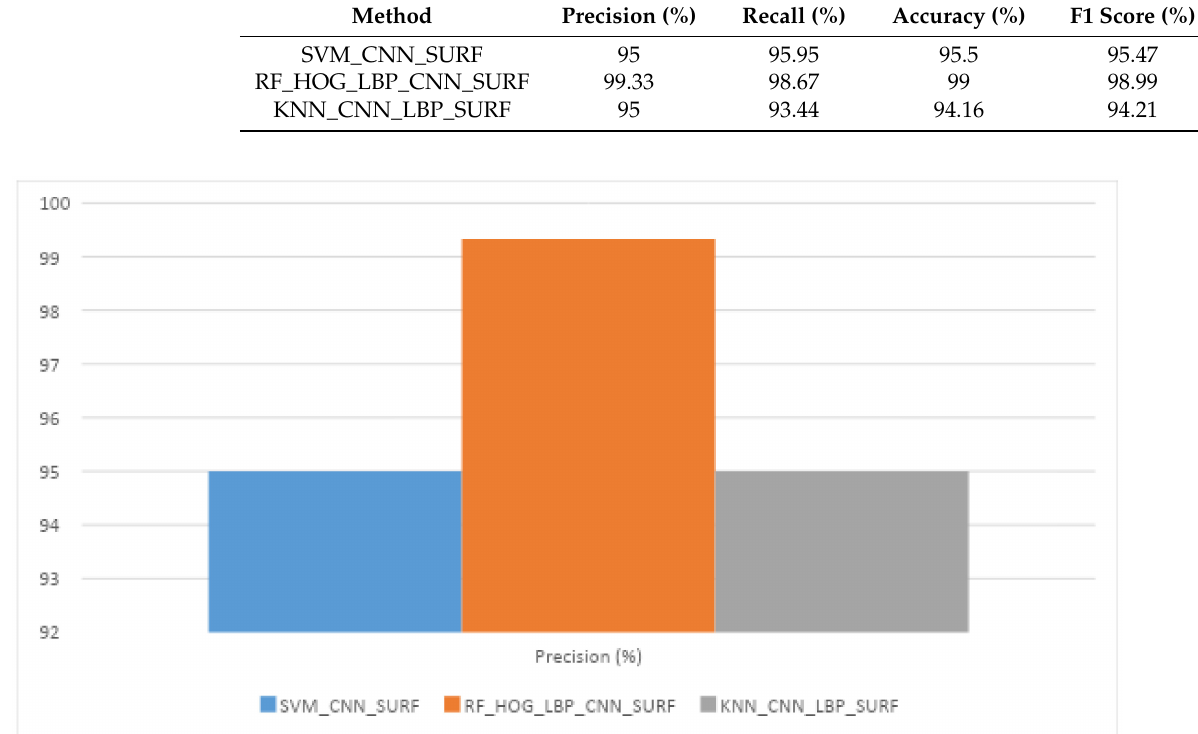
Figure 5. Best Performance results among all features descriptor with KNN, RF, and